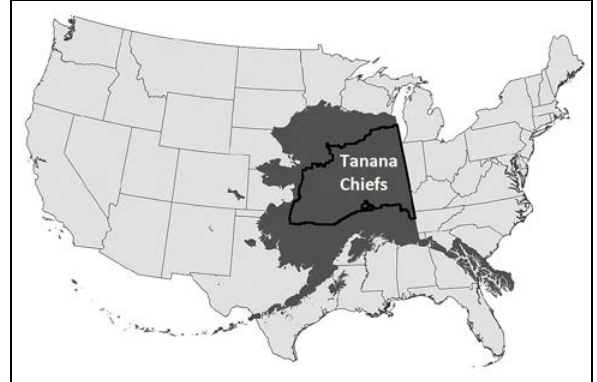
Figure 1. Map comparing the area of the Tanana Chiefs Conference (thick black line), Alaska (dark gray), relative to the lower-48 United